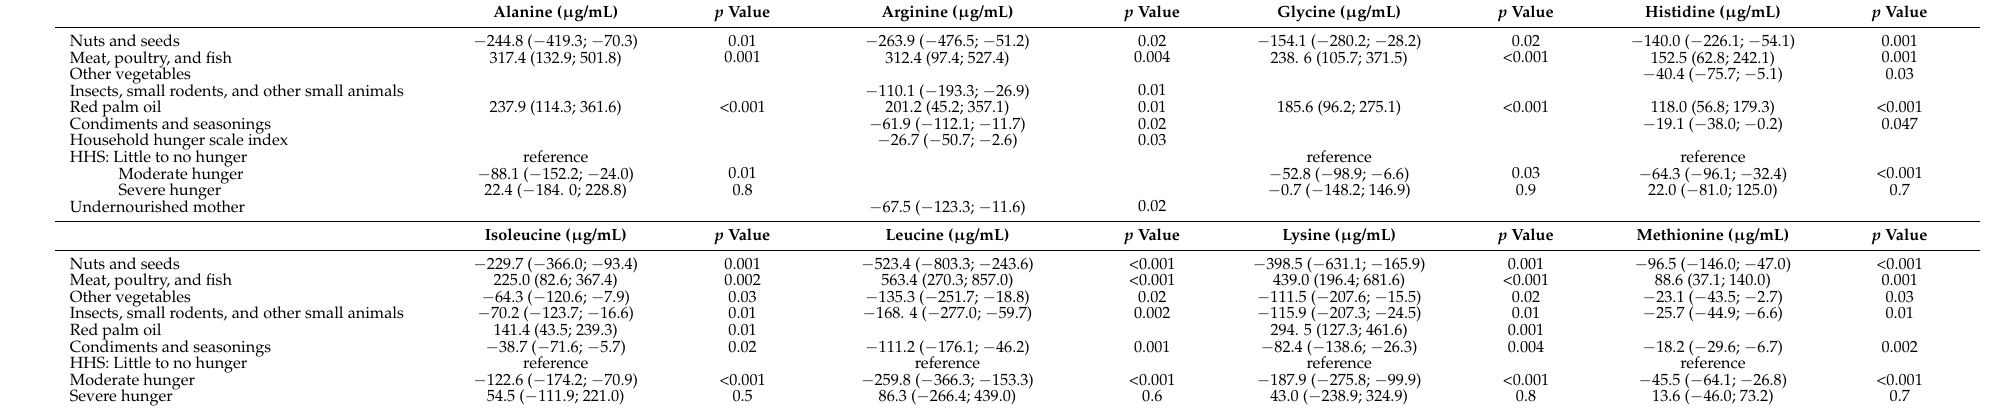
Table 7. Multilevel models of the dietary determinants of human milk total amino acids during the first 6 months of life (1).